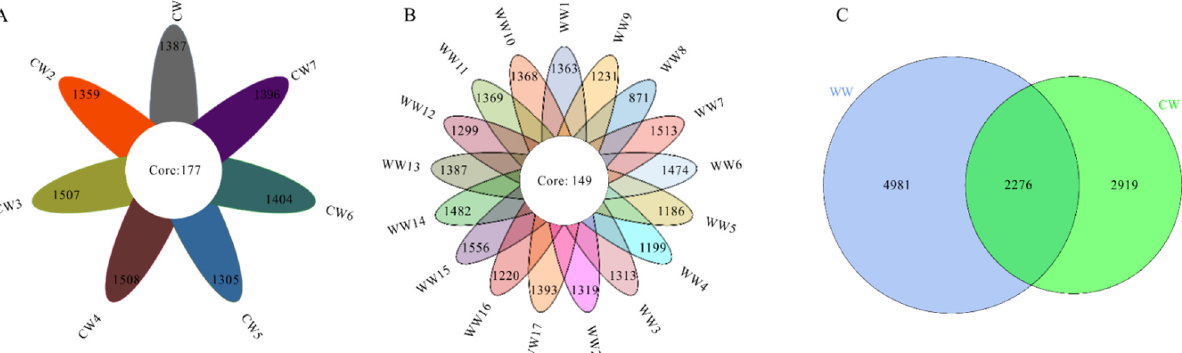
Figure 1. Venn and flower diagrams analysis of shared ASVs. Flower diagram shows number of ASVs that were shared (in the center) and total ASVs in each sample (in the petals) between captive (CW) and wild (WW) white-lipped deer. ( A , B ) Number of ASVs specific to CW and WW individuals, respectively; ( C ) number of ASVs shared by CW and WW.